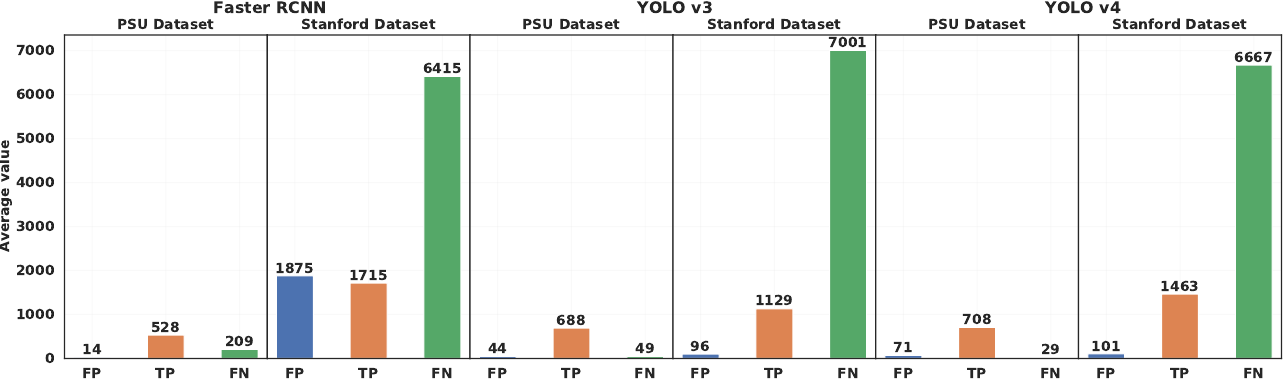
Figure 7. Average number of false positives (FP), false negatives (FN), and true positives (TP) for YOLOv3, YOLOv4, and Faster R-CNN on the two datasets.